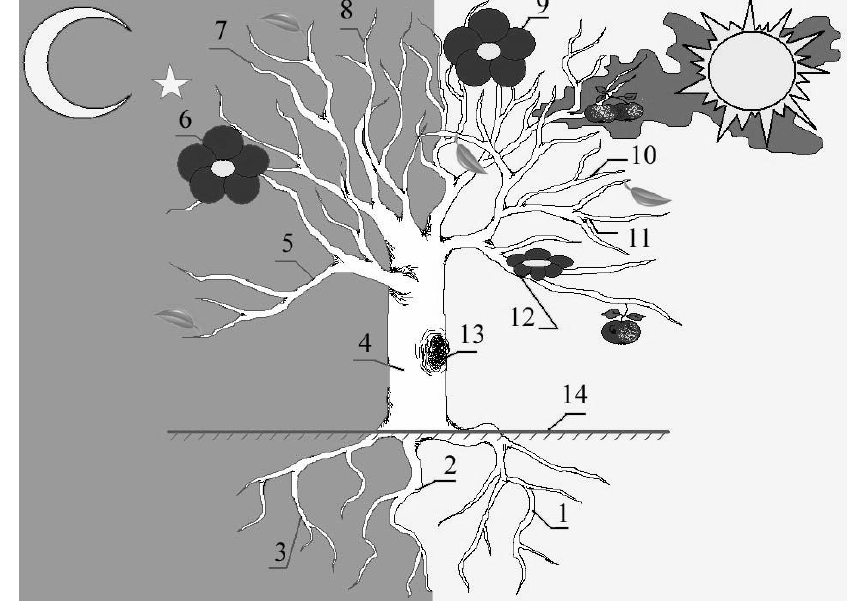
Fig.1. Schema-pattern “Professional functioning of specialist” (by T.V.